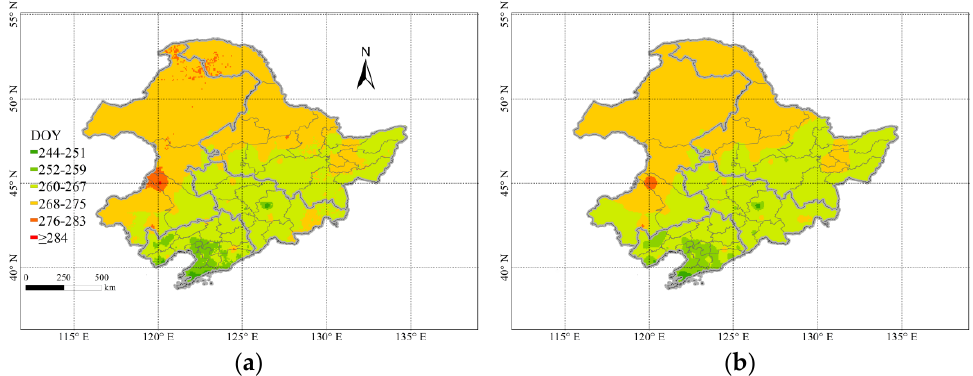
Figure 11. Maize harvesting stage (R6) in Northeast China (( a ) fusion data; ( b ) original data).